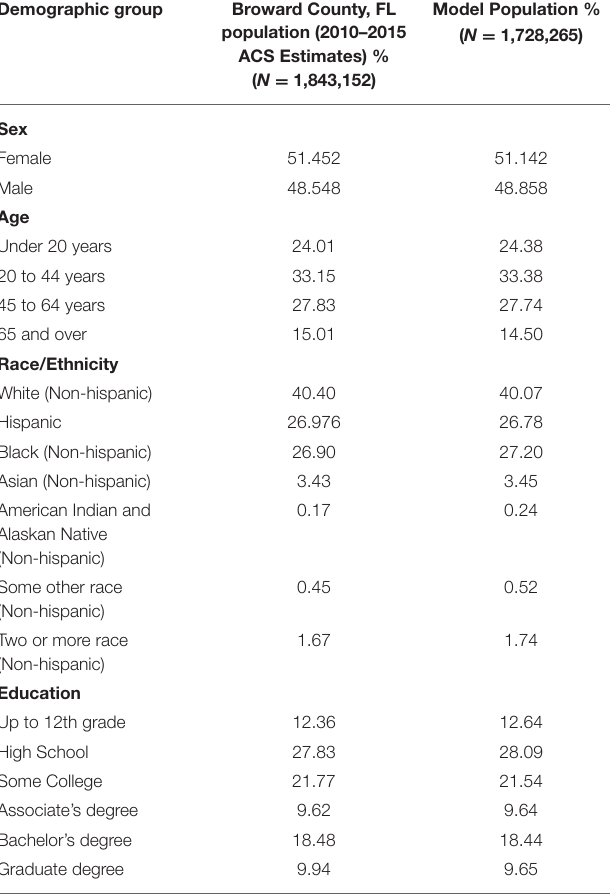
TABLE 1 | Comparison of Broward County American Community Survey (ACS) estimates with model synthetic population. Demographic